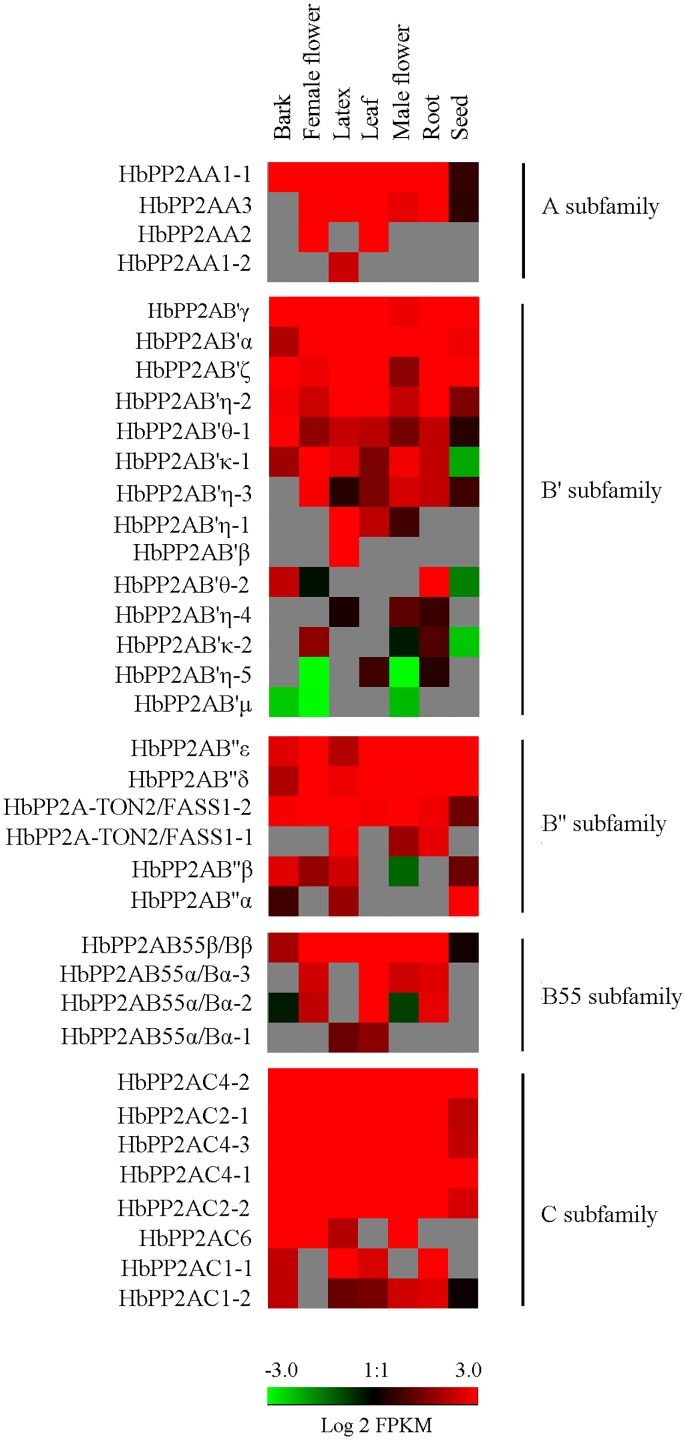
Expression analyses of HbPP2As base on the published transcriptome data.Red color indicated high expression while green represented very low expression. Grey showed no expression data detected. Bar represented the Log 2 FPKM value.